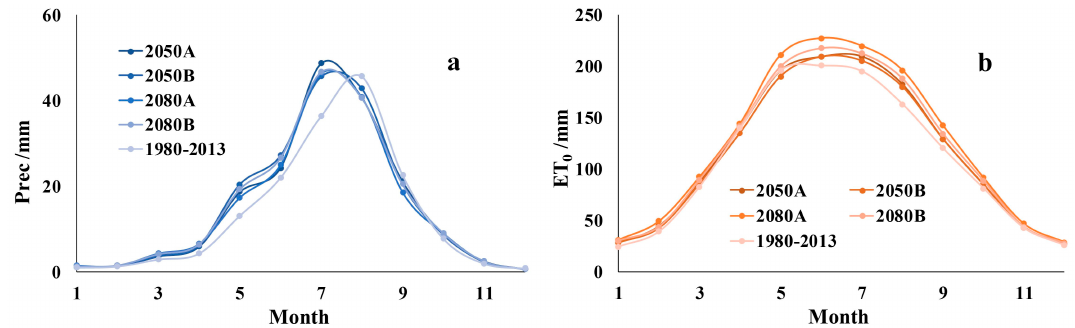
Figure 8. Monthly average ( a ) precipitation and ( b ) ET 0 in different time periods.